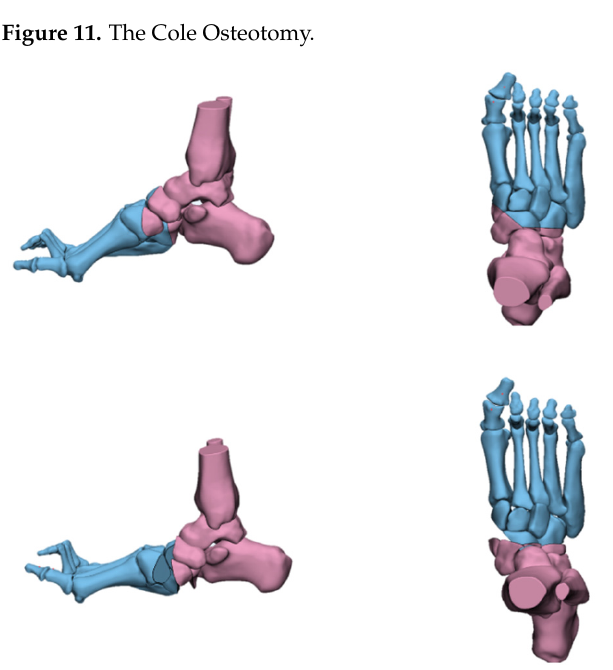
Figure 12. The Japas Osteotomy.